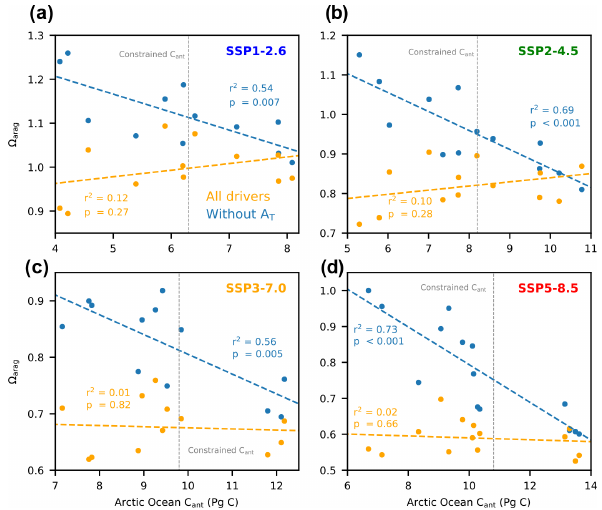
Figure 5. The CMIP6 ensemble relationship between end-of- century (cid:127) arag and the C ant inventory in the Arctic Ocean. Basin- wide (cid:127) arag averaged over the upper 1000m with (orange) and with- out (blue) taking into account concurrent changes in alkalinity ( A T ) against the Arctic Ocean C ant inventory in the year 2100 for (a) SSP1-2.6, (a) SSP2-4.5, (c) SSP3-7.0, and (d) SSP5-8.5.